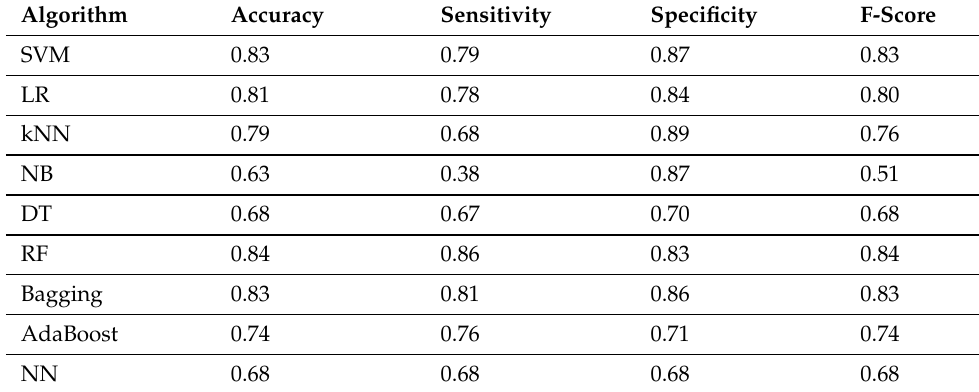
Table 3. Results with 75–25% train-test split.